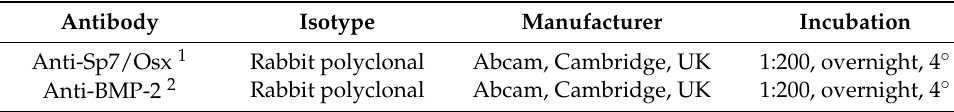
Table 4. Antibodies used for immunohistochemical